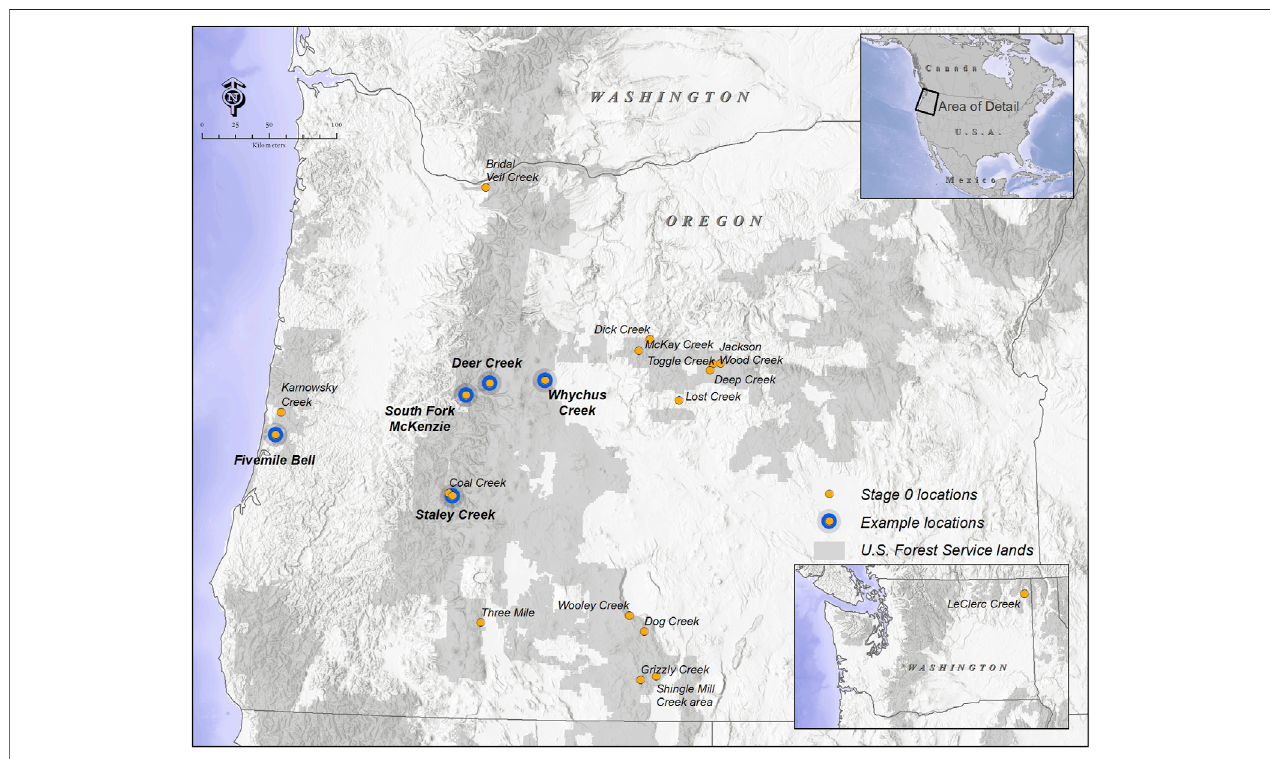
FIGURE 2 | Restoration projects targeting a Stage 0 condition were identi fi ed in the Paci fi c Northwest, United States, and primarily in Oregon. Projects were identi fi ed based on project goals to restore reconnect rivers to their fl oodplain at a valley scale allowing for the development of longitudinal, lateral, and vertical hyrologic